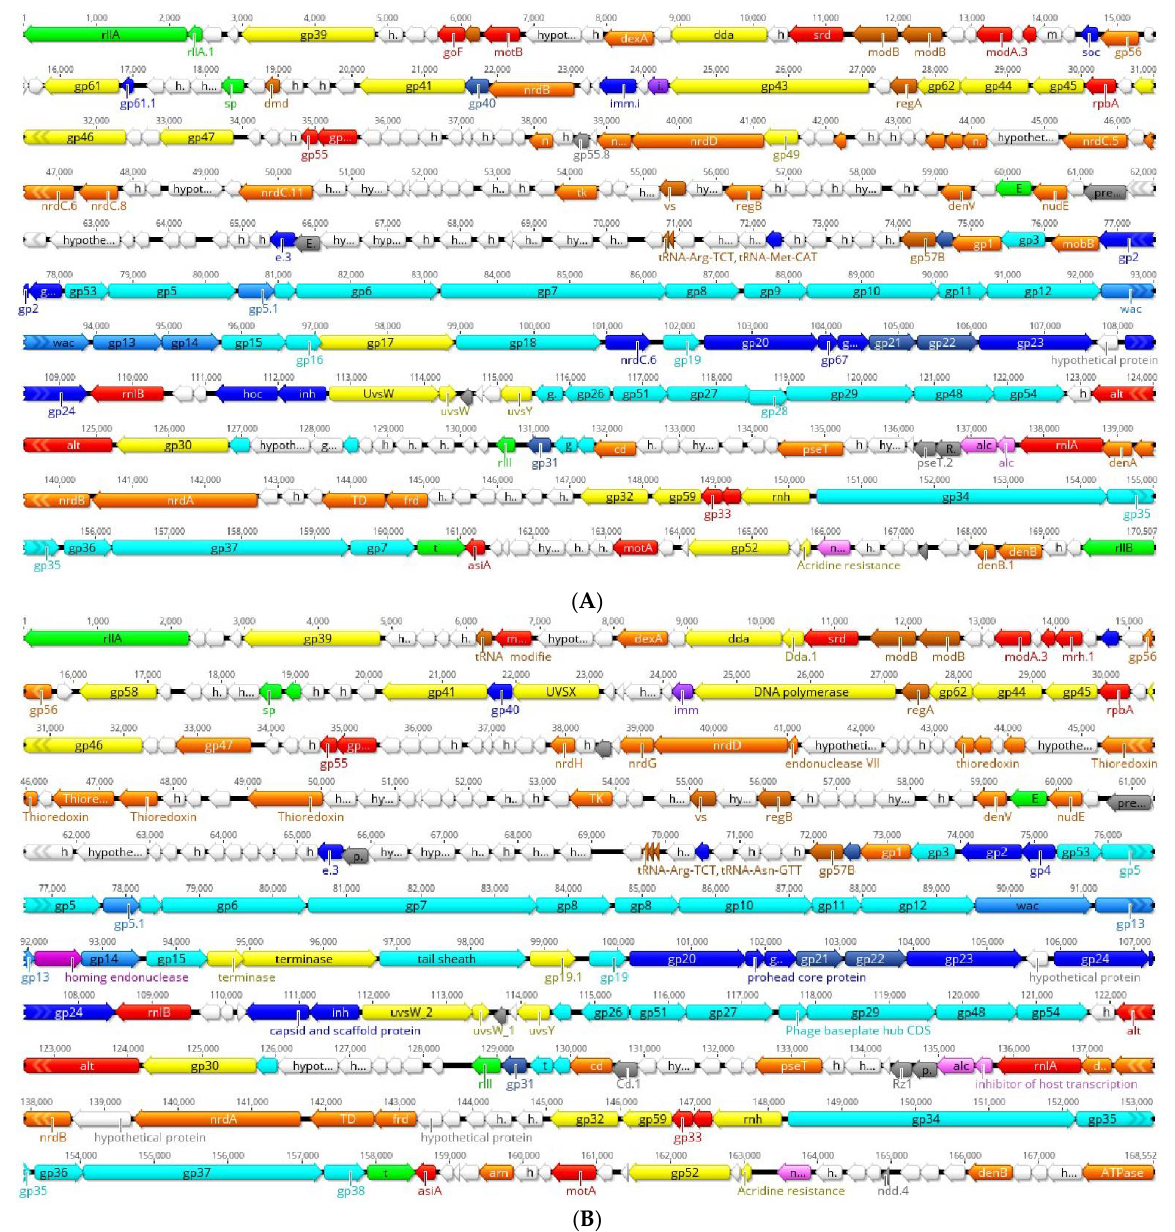
Figure 2. Genomic organisation and structure of Y. pestis Gaprivervirus bacteriophages MHS112 ( A ) and GMS130 ( B ). The red and brown arrows indicate transcription- and translation-associated genes, respectively; the green arrows indicate lysis-associated genes; and the yellow arrows indicate genes with corresponding DNA replication, recombination, repair, packaging, and processing functions. The dark blue, medium blue, and light blue arrows indicate the head, neck, and tail genes, respectively, and the stippled blue arrows indicate chaperonins/assembly catalysts genes. The purple and pink arrows indicate host or bacteriophage interactions and host alteration/shut off genes, respectively. The peach arrows indicate homing endonucleases and homologous genes. The grey arrows indicate predicted integral membrane or periplasmic proteins, and the white arrows indicate genes with unknown function.